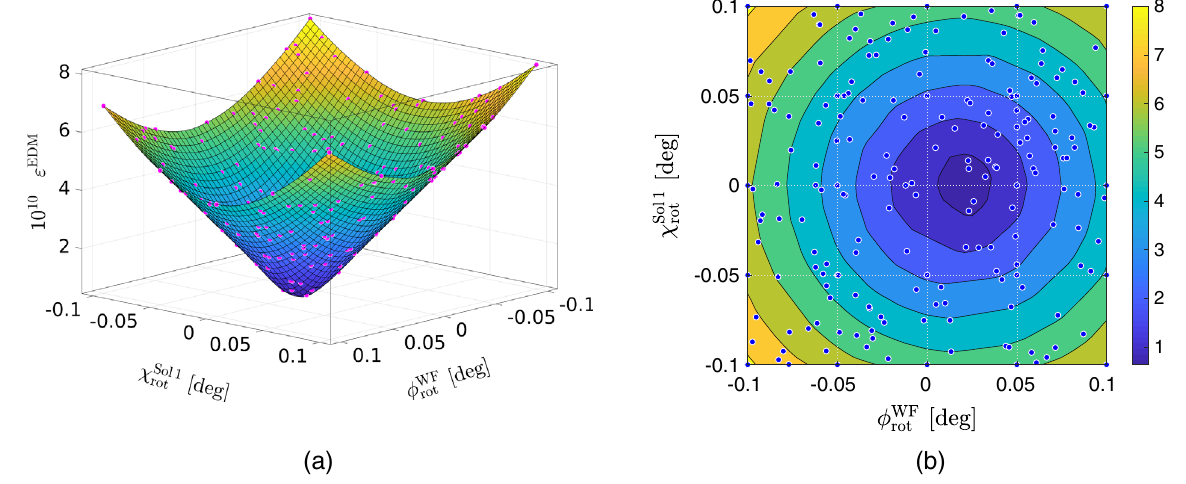
¼ ½ − 0 . 1 ° ; … ; þ 0 . n 1 ° (cid:2) rot